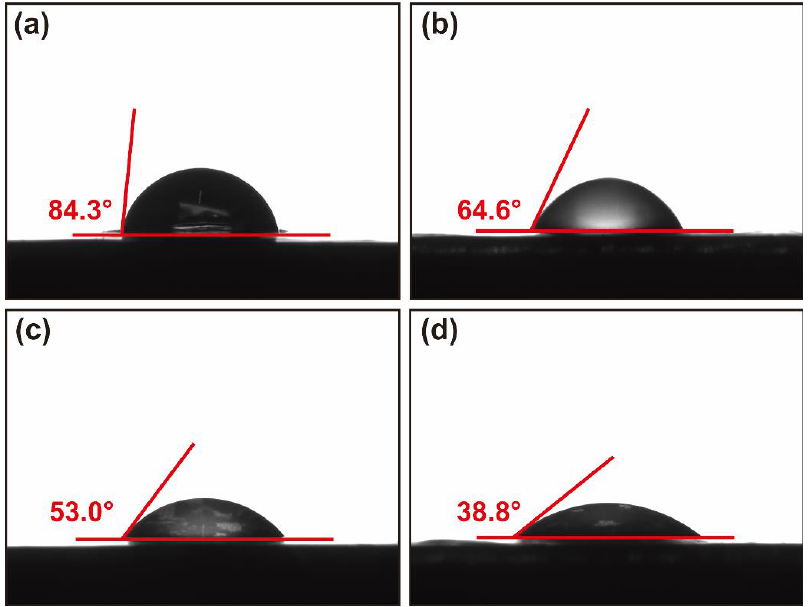
Figure 3. The water contact angle of the SS/agar films. SS: agar = 0:1 ( a ), SS: agar = 1:1 ( b ), SS: agar = 2:1 ( c ), and SS: agar = 3:1 ( d ).